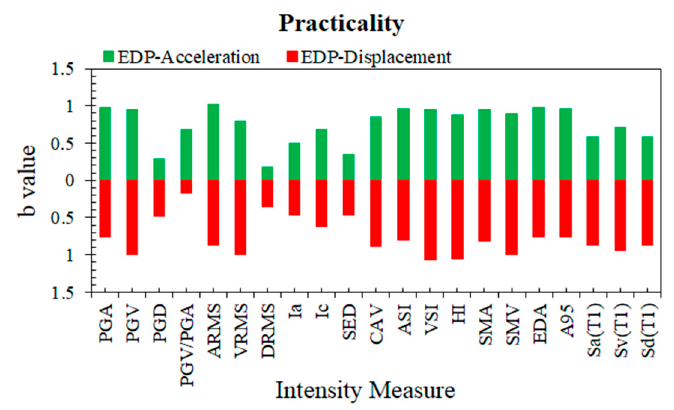
Figure 7. Practicality comparison.